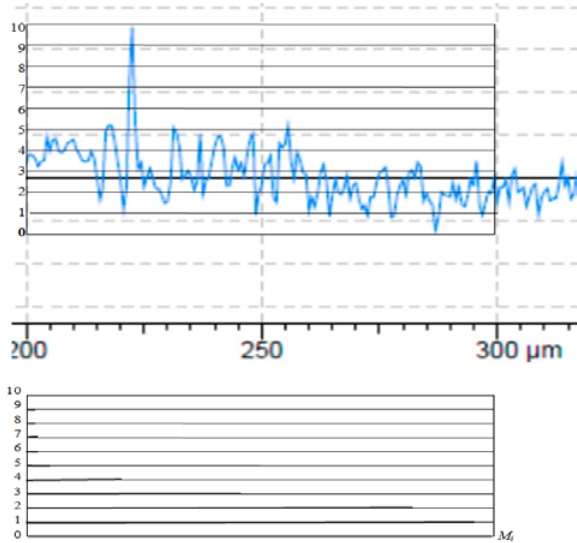
Fig. 7. Profilogram and diagram of filling the rough layer with a material along the 200-300 section of the profilogram depicted on fig.